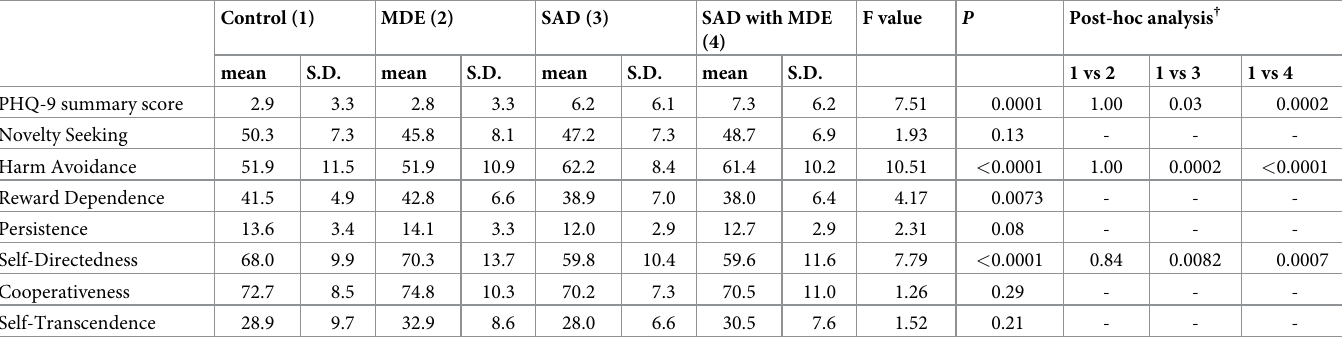
Table 2. Predictors of SAD and MDE at the time of enrollment